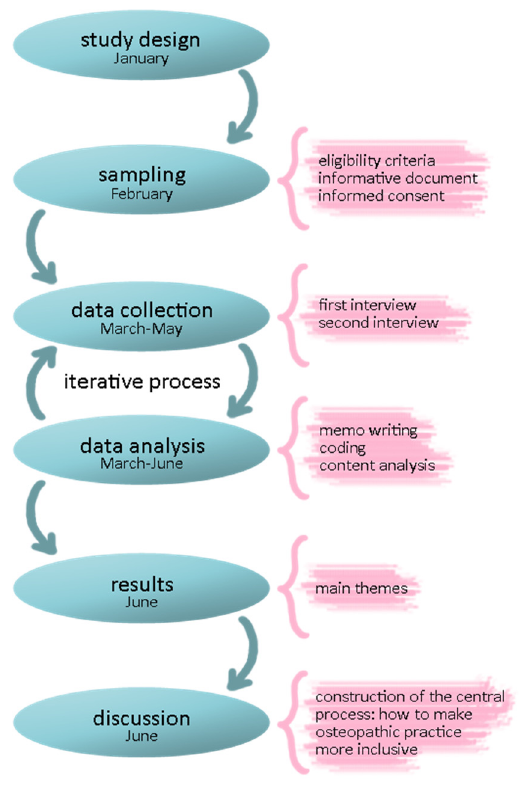
Figure 1. Study design and methods.